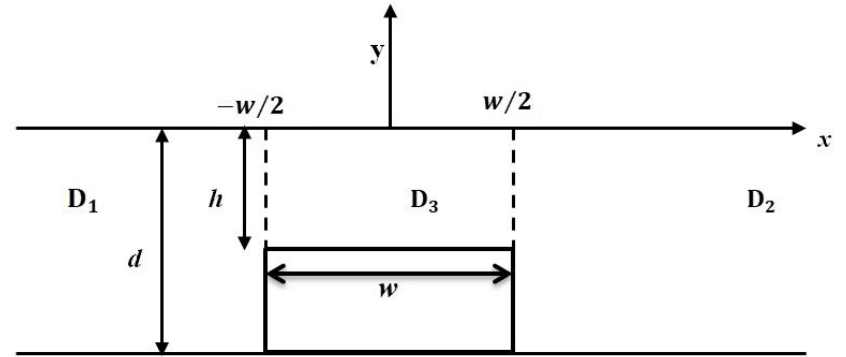
Figure A1. Domain of study.